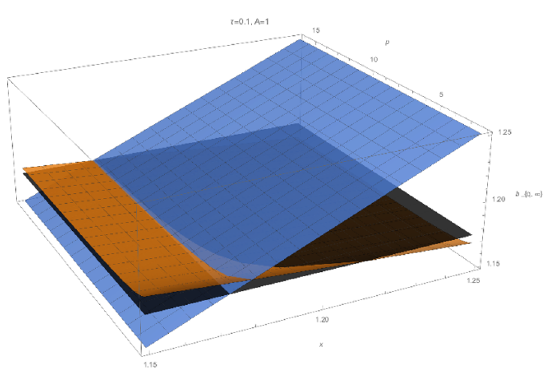
Figure 11 . Plot of b q, ∞ as a function of p , at A = 1 and τ = 0 . 1 . The blue surface is the function x on the left-hand side of (A.1). The orange surface is the right-hand side of (A.1) as a function of p and x . b q, ∞ is determined by the intersection of these two surfaces. The black horizontal surface is the asymptotic value b ∞